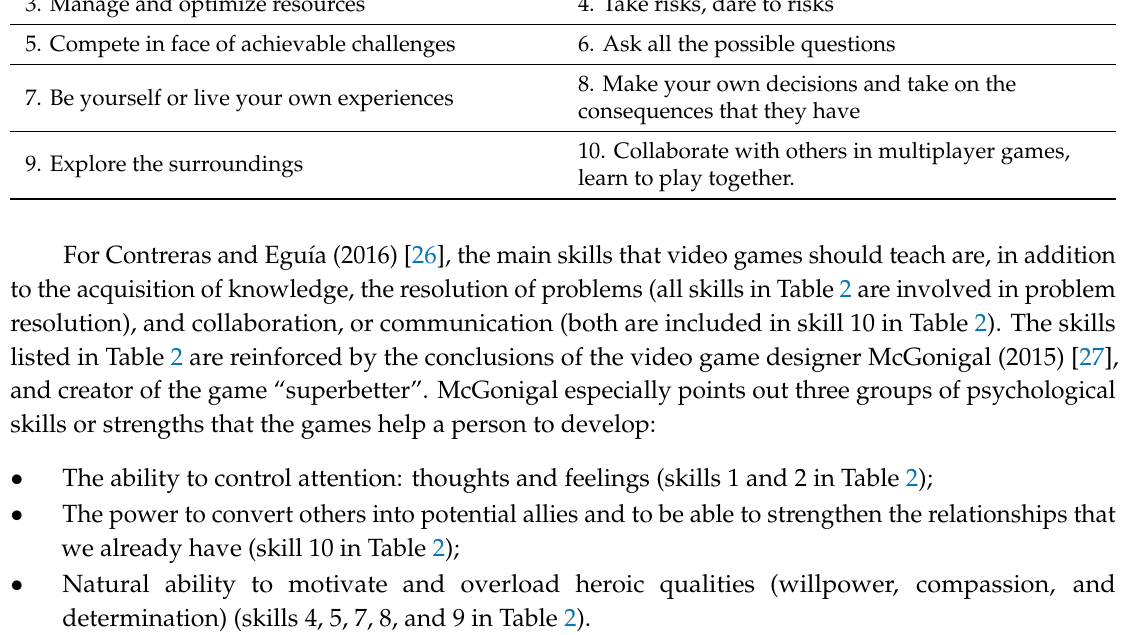
Table 2. Gamification and skills acquired by the video game player. Source: Humberto Cervera (2012) [24]. 1. Have purposes that get